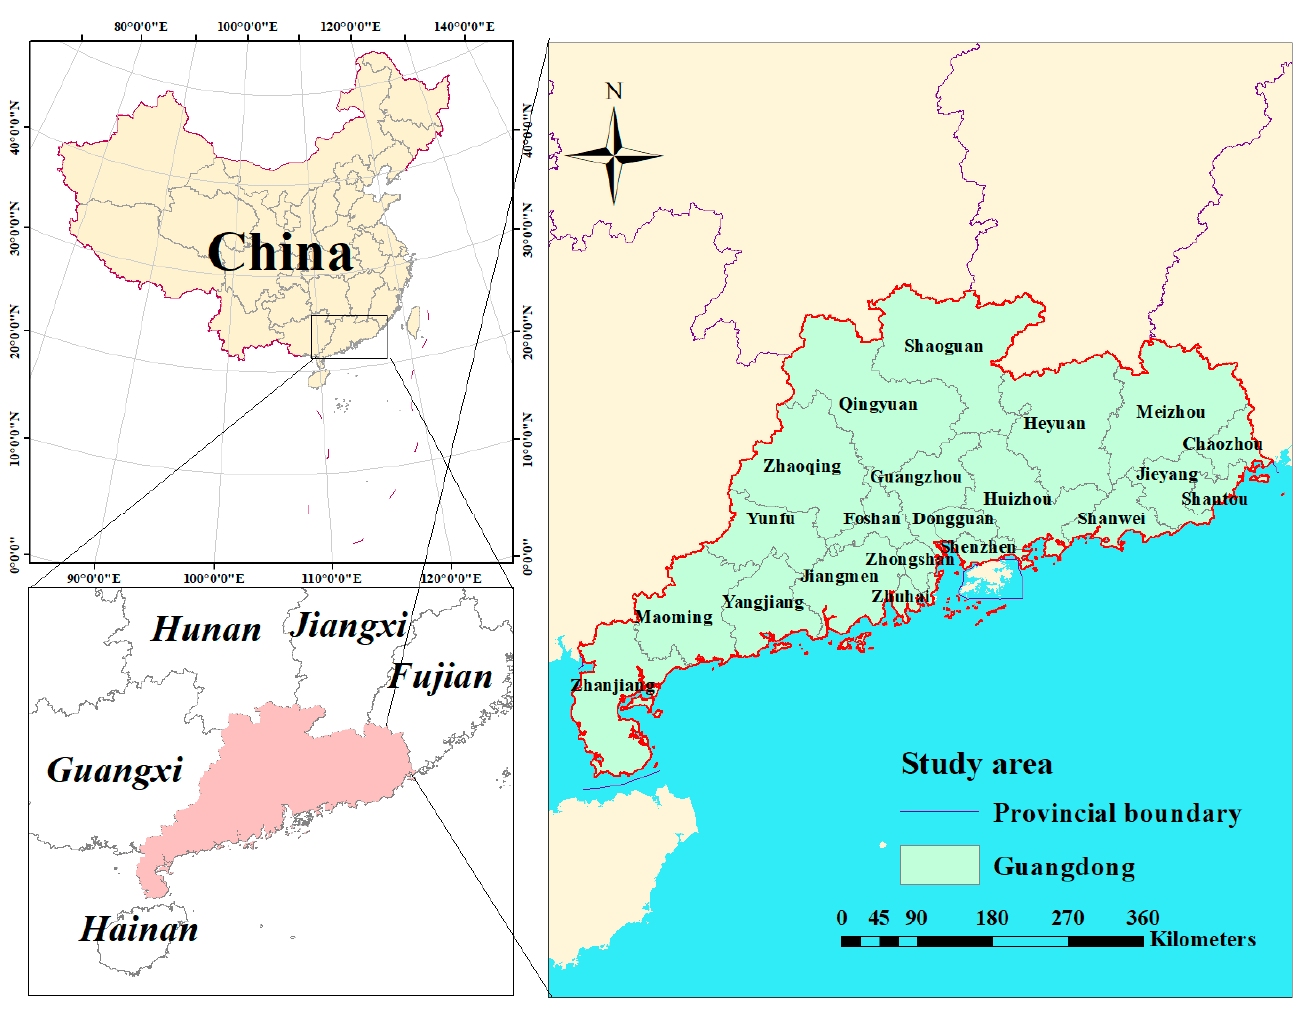
Figure 1. Locations of urban